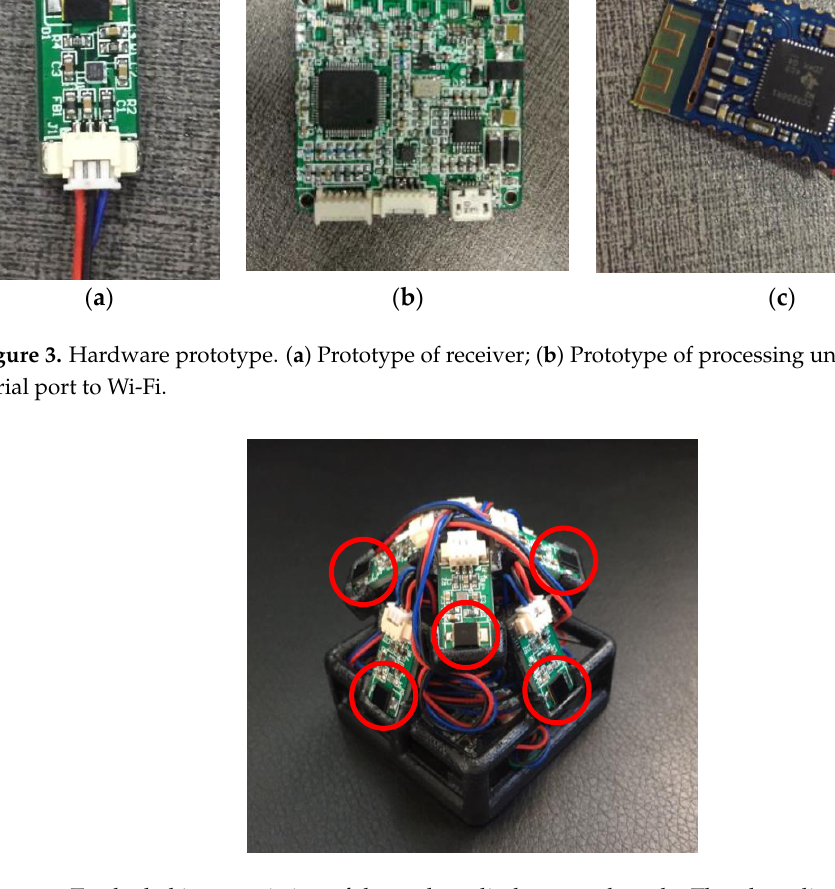
Figure 4. Tracked object consisting of three photodiode sensor boards. The photodiodes are circled in red.